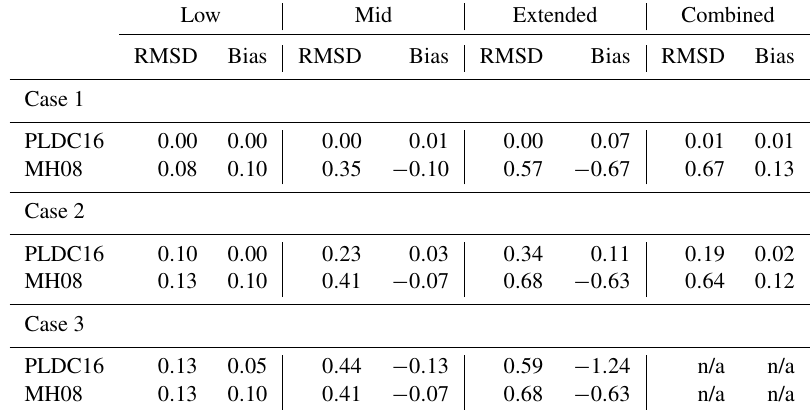
Table 3. Root mean square deviation (RMSD) and bias (kgm − 2 ) for PLDC16 and MH08 retrievals from simulated signals for the low, mid and extended regimes (excluding overlap). Results from three cases are provided. Case 1 uses noiseless simulated brightness temperatures with perfect auxiliary information. Case 2 uses simulated brightness temperatures with Gaussian noise and perfect auxiliary information. Case 3 uses simulated brightness temperatures with Gaussian noise and a climatological auxiliary profile. Case 3 does not include a column for combined measurements because regime selection requires better auxiliary information.